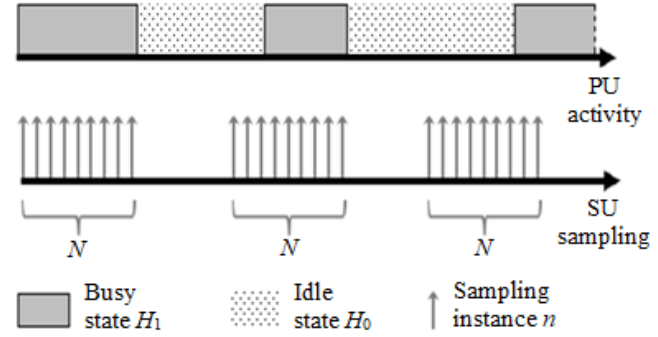
Figure 1. Illustration of a dynamic PU signal activity along with the energy sampling